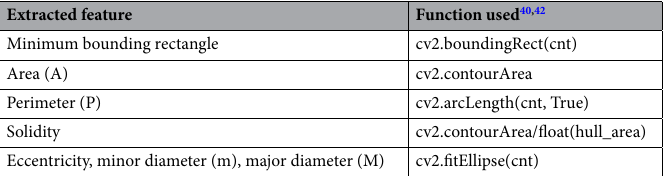
Table 1. List of size and shape features extracted from images using OpenCV library